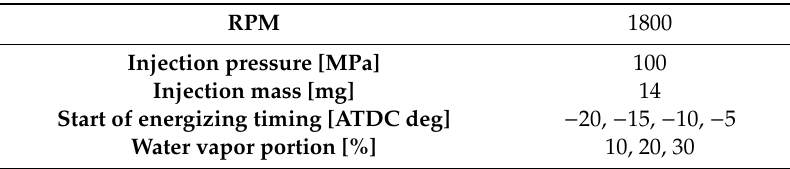
Table 4. Detailed numerical analysis conditions.